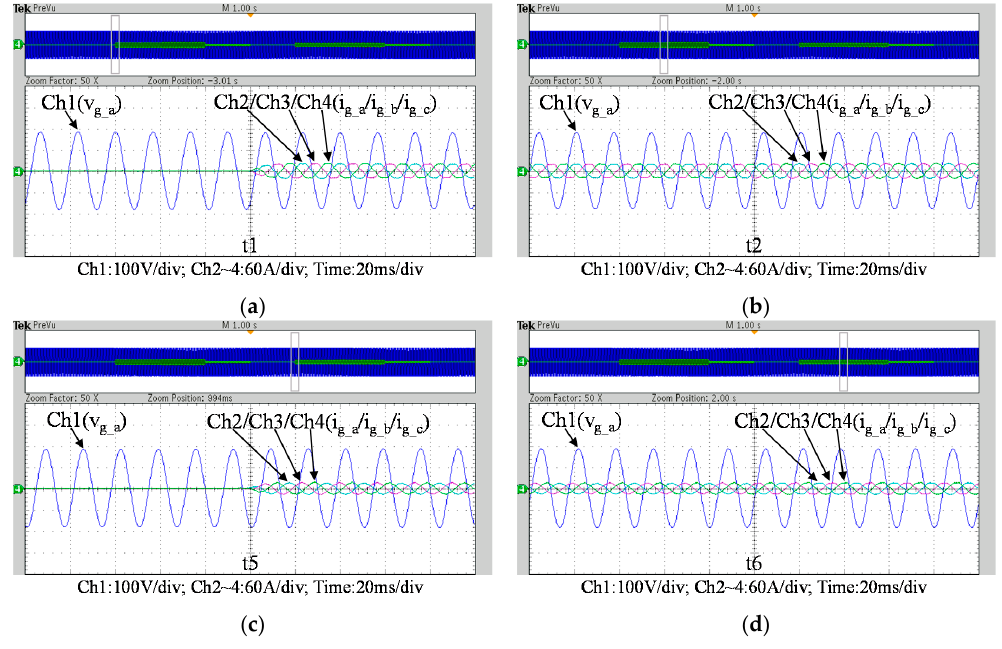
Figure 34. Detailed view of Figure 33: ( a ) near t1; ( b ) near t2; ( c ) near t5; ( d ) near t6.